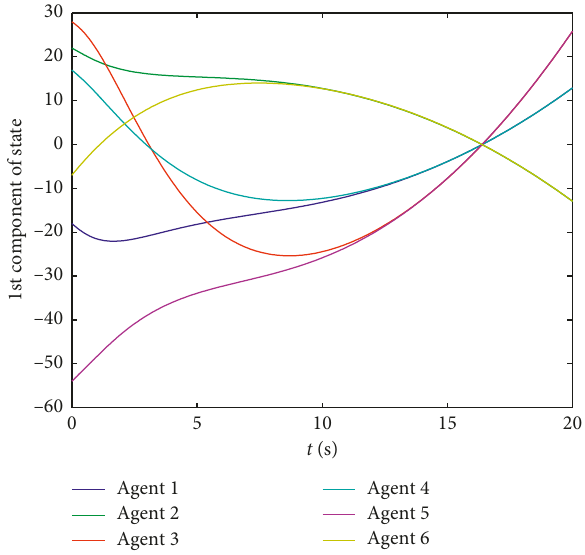
Figure 1: Trajectories of x